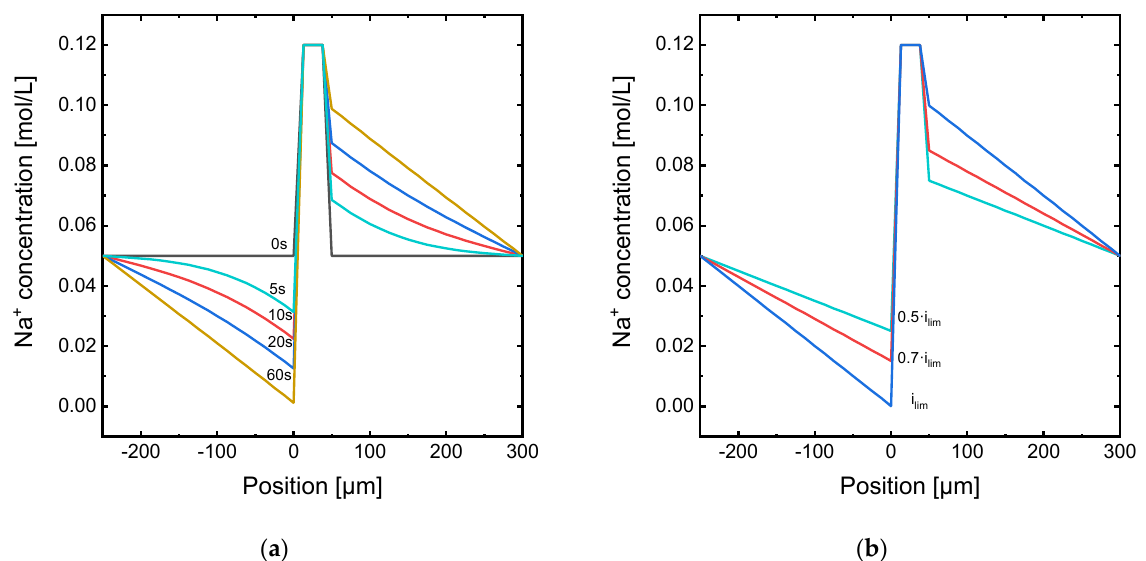
Figure 3. Na + concentration profile along the diffusion boundary layers for the membrane system under: ( a ) application of i lim at different times; ( b ) application of different current densities once the steady state is achieved.